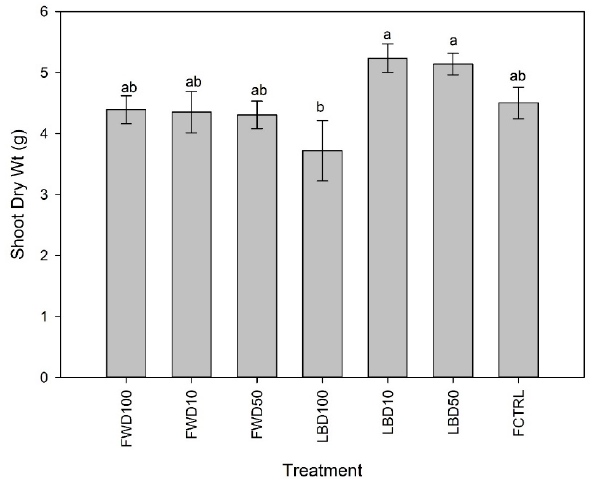
Figure 1. Digestate and fertilizer effects on kai choy shoot dry weight in a controlled greenhouse experiment. Error bars are the standard error of the mean ( n = 5), and means that do not share a letter are not significantly different ( p < 0.05).